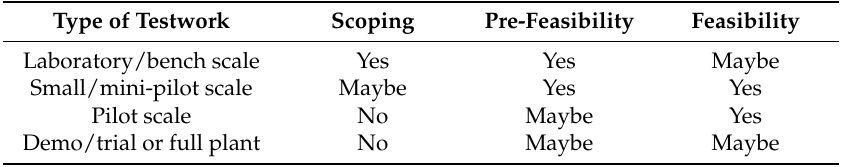
Table 6. Recommended scale of metallurgical testwork for engineering studies (after